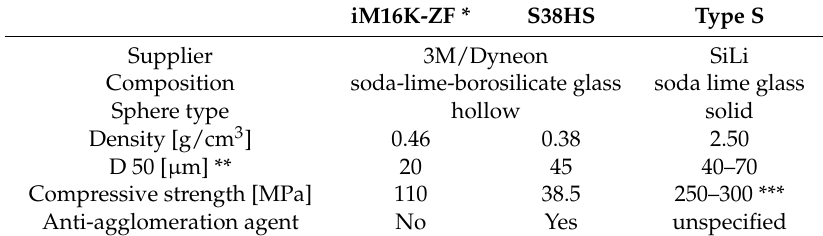
Table 1. Relevant properties of the examined Micro Solid Glass Spheres (SMGS) and Micro Hollow Glass Spheres (MHGS).